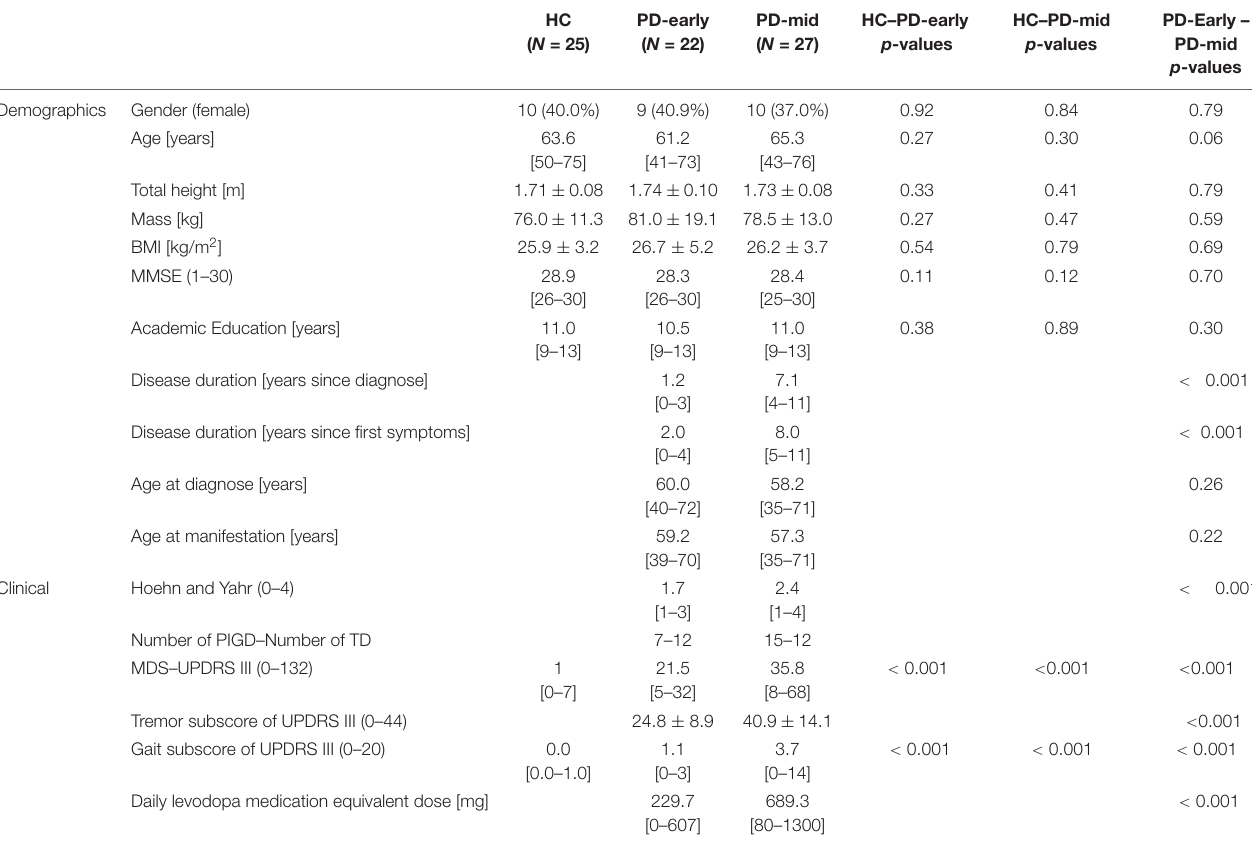
TABLE 1 | Demographics and clinical data of participants at baseline (first